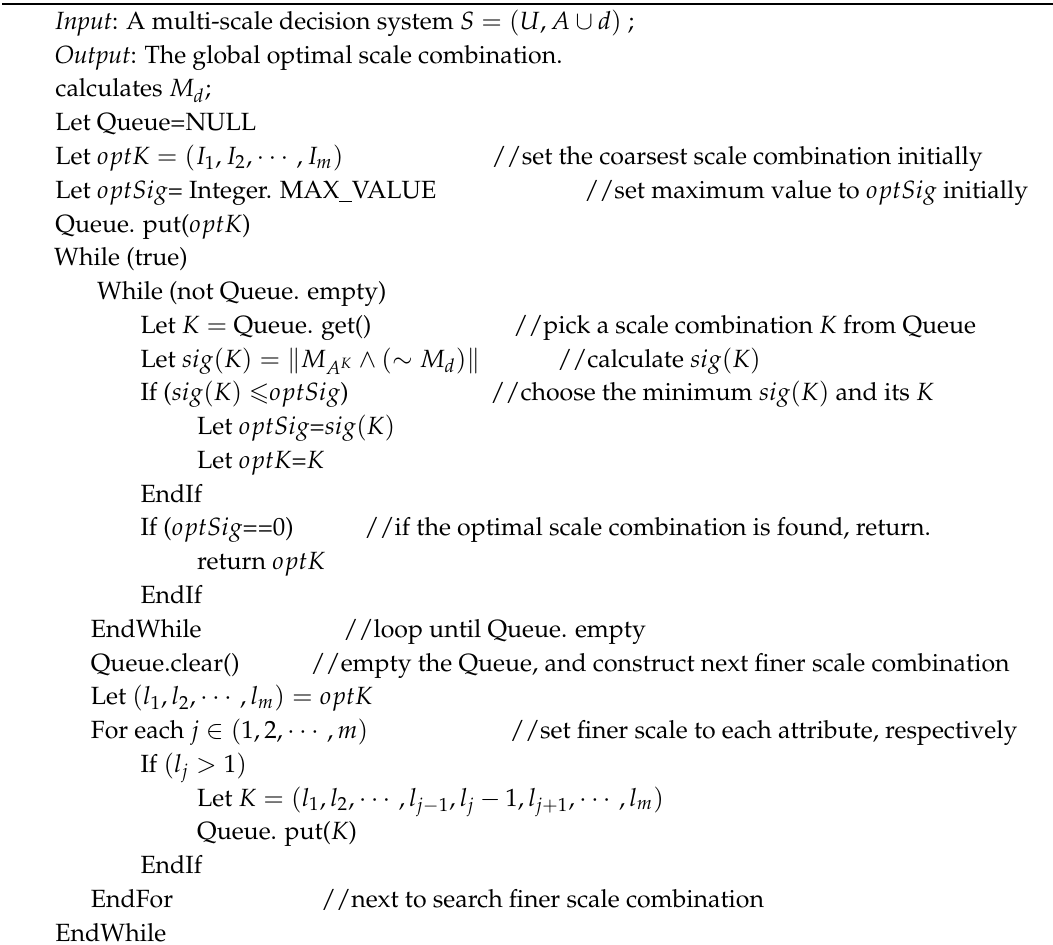
Algorithm 1: Selecting the global optimal scale combination of a multi-scale decision